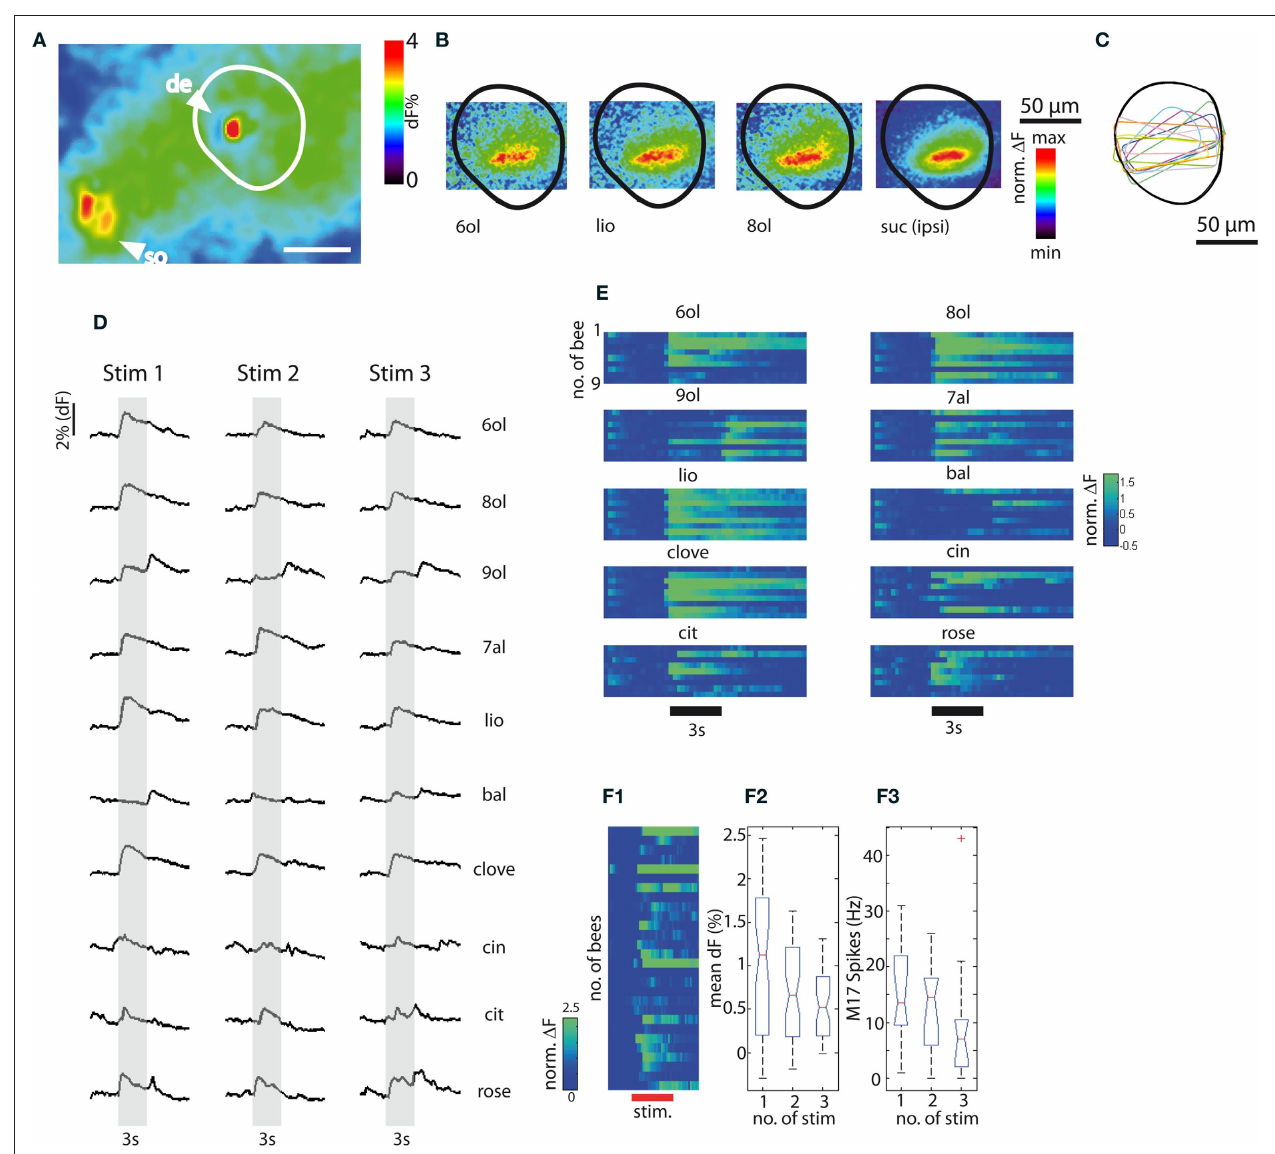
FiGure 2 | Calcium signals recorded in PCT neurons. (A) Spatial distribution of the Ca 2 + signal in response to heptanal (7al) in the somata (so) and dendrites (de) of PCT neurons, scale bar: 100 μm. (B) Spatial distribution of Ca 2 + signals in the dendrites of the median α L recorded with a 60 × objective in response to stimulation with odors and sucrose. 6ol: hexanal, lio: linalool. 8ol: octanal, suc (ipsi): sucrose stimulation of the ipsilateral antenna. (C) Regions of interest (ROI) of nine representative preparations. (D) Representative examples of the temporal dynamics of Ca 2 + signals in response to three repeated stimulations with 10 odors (6ol: hexanol, 8ol: octanol, 9ol: nonanol, 7al: heptanal, lio: linalool, bal: benzaldehyde, clove oil, cin: cineol, cit: citral, rose oil). (e) Temporal